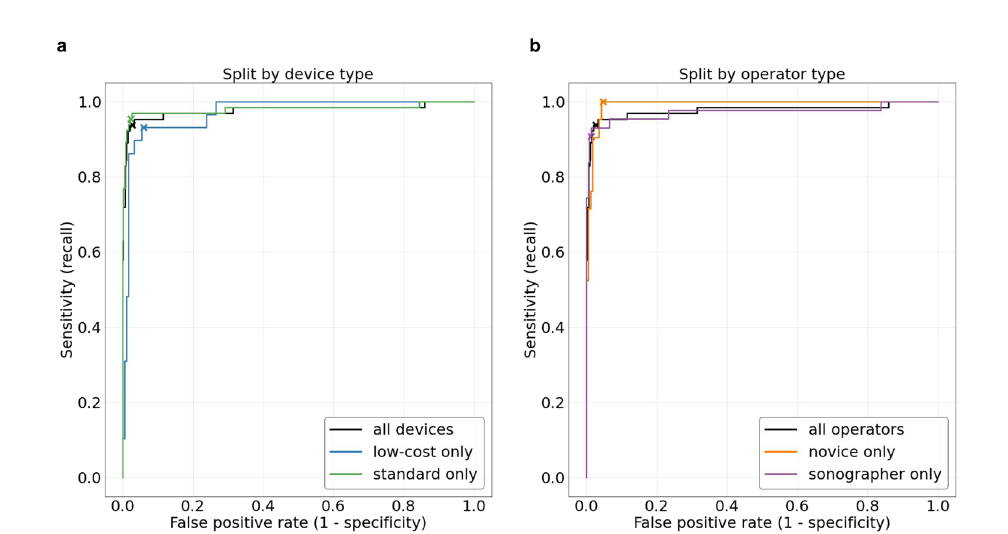
Fig. 3 Fetal malpresentation estimation. n = 623 study participants. Receiver operating characteristic (ROC) curves for fetal malpresentation estimation. Crosses indicate the prede fi ned operating point selected from the tuning dataset. a ROC comparison based on the type of device: low-cost and standard. b ROC comparison based on the type of ultrasound operator: novices and